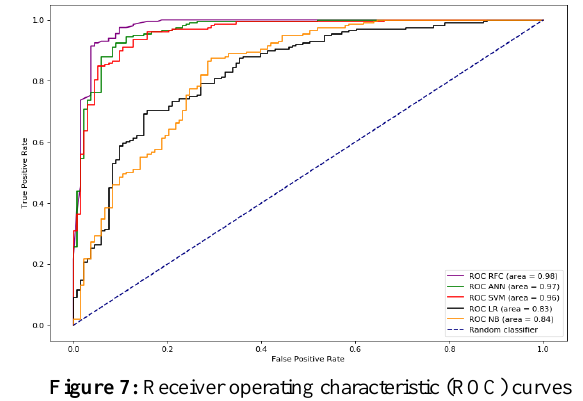
Figure 7: Receiver operating characteristic (ROC) curves